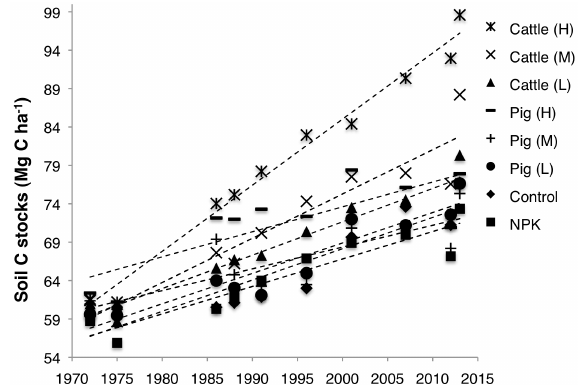
Figure 1. Changes in soil C stocks from 1970 to 2013 (0– 15cm soil depth) under either organic or inorganic nutrient ad- ditions or no nutrients (i.e. control). Nutrient application rates: NPK = 200kgN, 32kgP, 160kgKha − 1 yr − 1 ; Pig (L), Pig (M) and Pig (H) = Pig slurry applications at 50 (low), 100 (medium) and 200 (high)m 3 ha − 1 yr − 1 respectively; Cattle (L), Cattle (M), Cattle (H) = Cattle slurry applications at 50 (low), 100 (medium) and 200 (high)m 3 ha − 1 yr − 1 respectively. Best fit linear func- tions (dashed lines): NPK ( y = 0.36 × –647; R 2 = 0.87); control ( y = 0.41 × –746; R 2 = 0.83); Pig (L) ( y = 0.39 × –723; R 2 = 0.88); Pig (M) ( y = 0.28 × –498; R 2 = 0.65); Pig (H) ( y = 0.31 × – 546; R 2 = 0.67); Cattle (L) ( y = 0.43 × –796; R 2 = 0.91); Cattle (M) ( y = 0.65 × –1230; R 2 = 0.95); Cattle (H) ( y = 0.86 × –1636; R 2 =